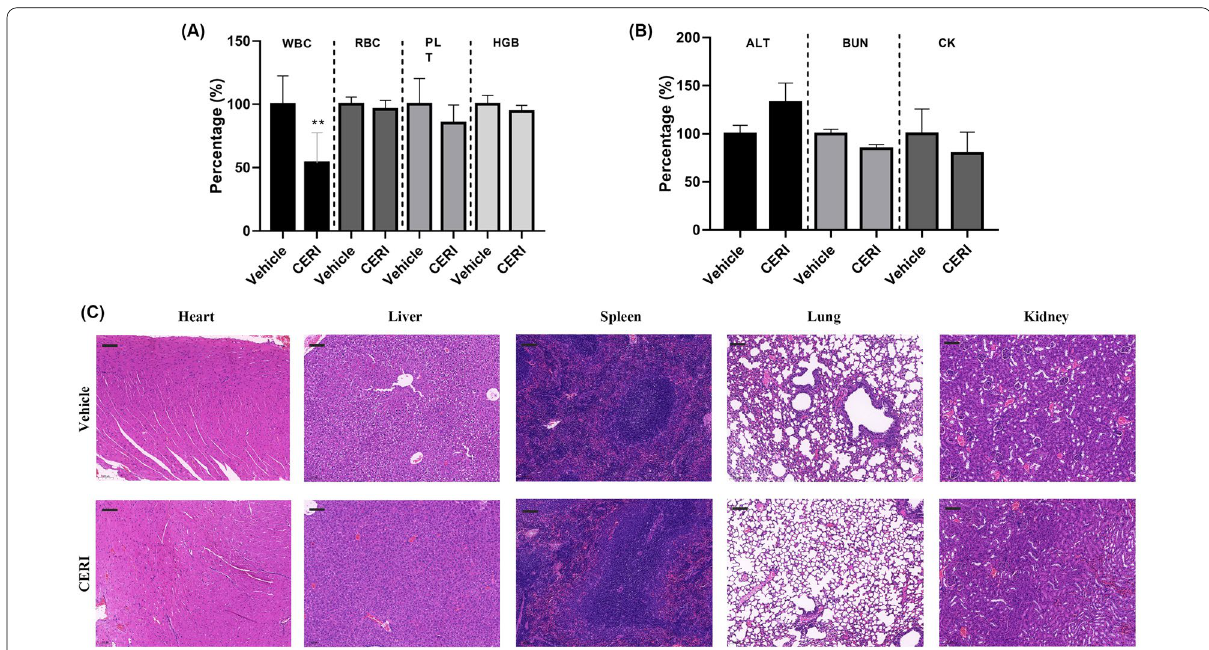
Fig. 5 Toxicological evaluation in vivo. Routine blood ( A ) and serum biochemistry examinations ( B ) were performed in the vehicle- and CERI-treated groups. WBC, white blood cell. RBC, red blood cell. PLT, platelet. HGB, hemoglobin. ALT, alanine transaminase. BUN, blood urea nitrogen. CK, creatine kinase. C Comparison of pathological changes in organ structure (heart, liver, spleen, lung, kidney) between the vehicle and CERI groups by H&E staining. Scale bars, 200